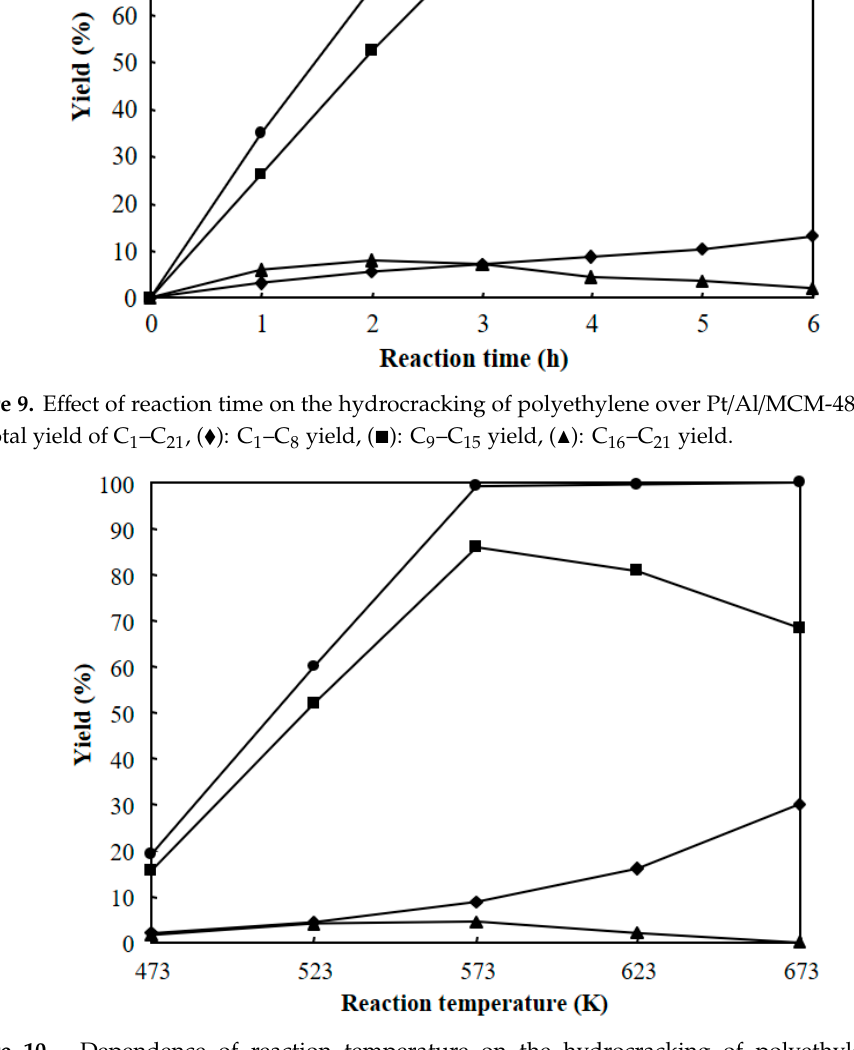
Figure 10. Dependence of reaction temperature on the hydrocracking of polyethylene over Pt/Al/MCM-48 for 4 h. ( ● ): total yield of C 1 ‒ C 21 , ( ♦ ): C 1 ‒ C 8 yield, ( ■ ): C 9 ‒ C 15 yield, ( ▲ ): C 16 ‒ C 21